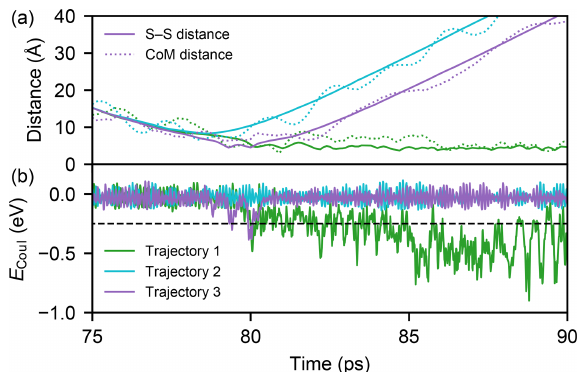
Figure 4. Three example MD trajectories with a relative velocity of 350ms − 1 and an impact parameter of 8.5Å after 50ps of energy relaxation and the first 25ps of collision simulation. Panel (a) shows both the distance between the two sulfur atoms (solid lines) and the centre-of-mass distance of the molecules (dotted lines) during the simulations. The electrostatic energies E Coul , which is used to de- termine the possible collision event, for successful (1), unsuccess- ful (2), and successful but instantly evaporating (3, continuously 0.18ps below the threshold) trajectories are shown in panel (b) with the threshold value (dashed black